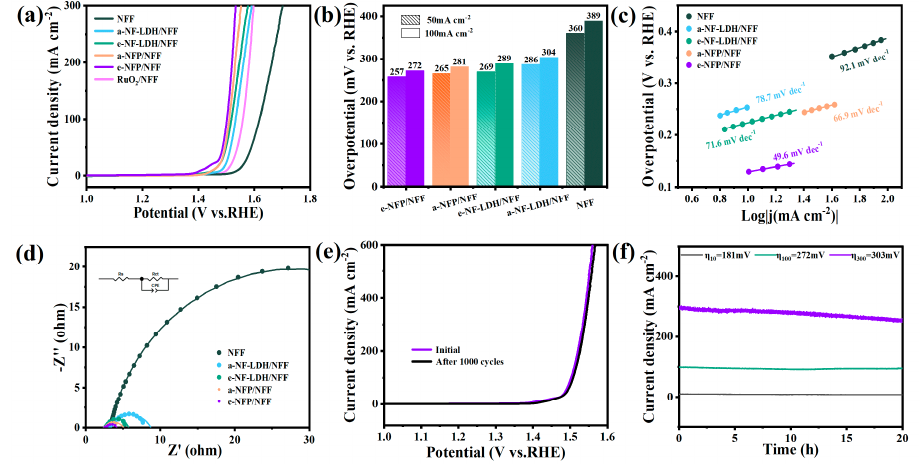
Figure 7. ( a ) OER polarization curves with iR − compensation for RuO 2 /NFF, NFF, a − NF − LDH/NFF, e − NF − LDH/NFF, a − NFP/NFF and e − NFP/NFF; ( b ) Overpotentials at 50 and 100 mA·cm − 2 ; ( c ) Tafel plots of the corresponding samples; ( d ) Nyquist plots; ( e ) LSV curves of e − NFP/NFF before and after 1000 cyclic test; ( f ) Time − dependent current density curve of e − NFP/NFF at overpotentials of 181, 272, and 303 mV.